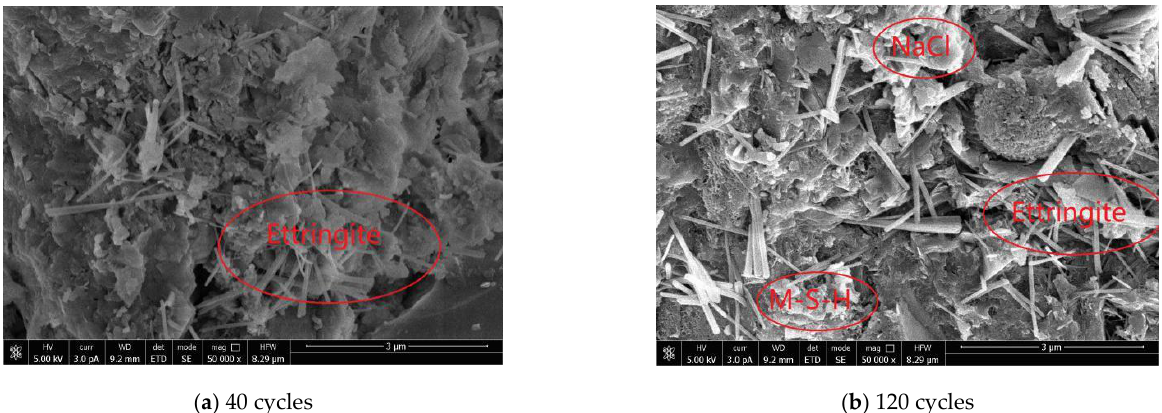
Figure 23. Microscopic morphology of MK concrete eroded by MgSO 4 + NaCl solution.